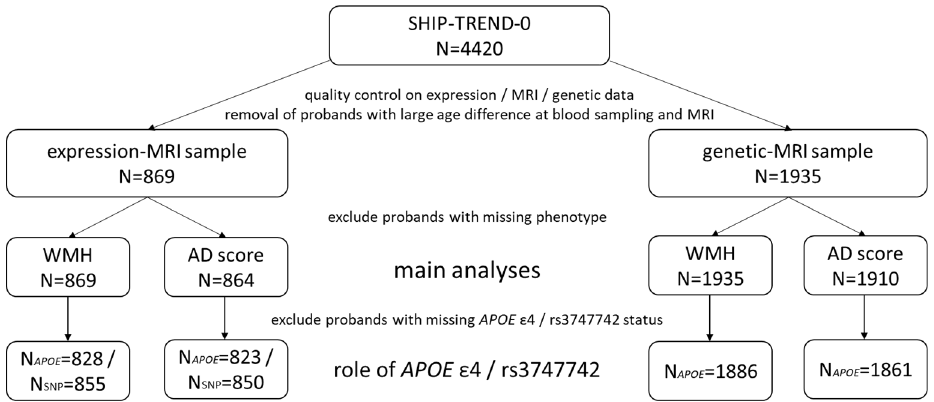
Figure 1. Overview of the sample sizes in the whole SHIP-TREND-0 sample and the subsamples used in this study. In total, we have used data from 1949 participants of SHIP-TREND-0. The expression-MRI and genetic-MRI samples comprise the overlap of participants with MRI data and gene expression or genetic data, respectively. Table 1. Sample description of the study population. The columns expression-MRI sample and genetic-MRI sample refer to the current study. Markedly, restricting the SHIP-TREND-0 sample to the two subsamples did not introduce a selection bias regarding the variables relevant for our study. The variables marked with * were only measured on a subset of SHIP-TREND-0. Numerical variables are listed as mean (standard deviation), categorical variables as number (percentage). For the three main variables we additionally provide the first quartile, median and third quartile in square brackets. #NA is the number of missing values.